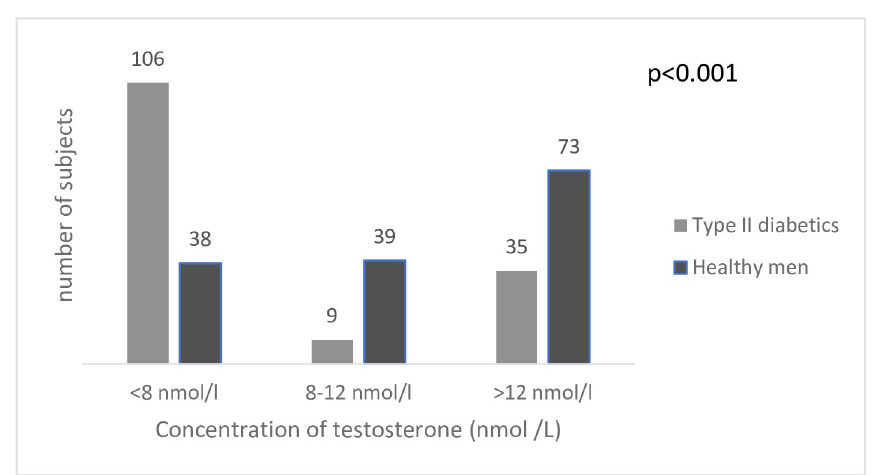
Fig 3. Percentage distribution of categorized testosterone levels.